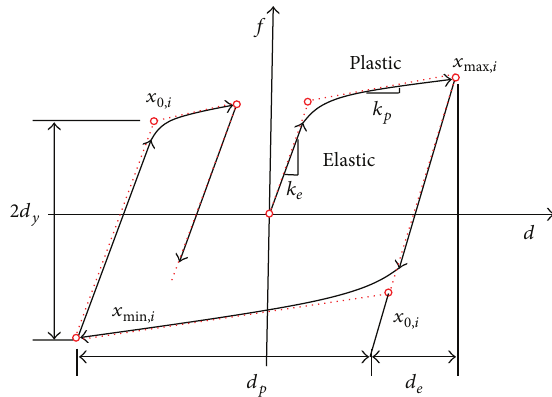
Figure 1: Hysteretic loops for arbitrary